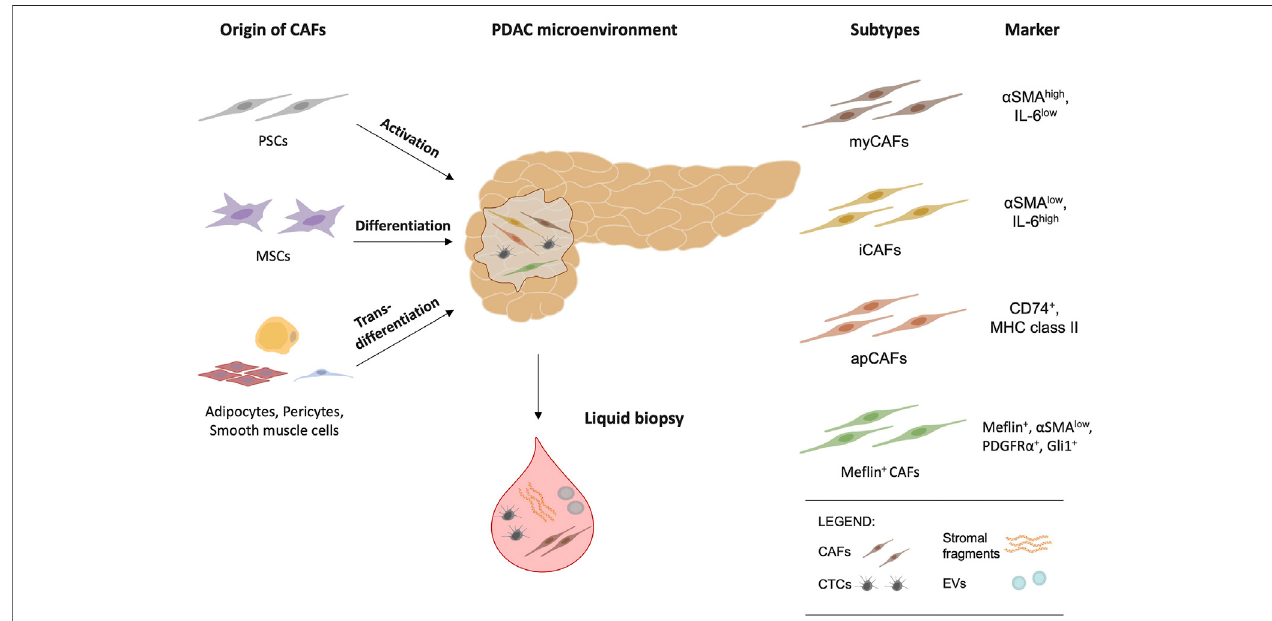
FIGURE 1 | Cancer-associated fi broblasts (CAFs) have multiple origins and arise from pancreatic stellate cells (PSCs), mesenchymal stem cells (MSCs), adipocytes, pericytes, and smooth muscle cells. Myo fi broblastic CAFs (myCAFs), in fl ammatory CAFs (iCAFs), antigen-presenting CAFs (apCAFs) and Me fl in-positive CAFs are the major CAF subtypes and re fl ect functional diversity. As potential biomarkers, circulating tumor cells (CTCs), circulating (c)CAFs, stromal fragments, and extracellular vesicles (EVs) are an emerging area of research in liquid biopsy and offer future clinical implications.